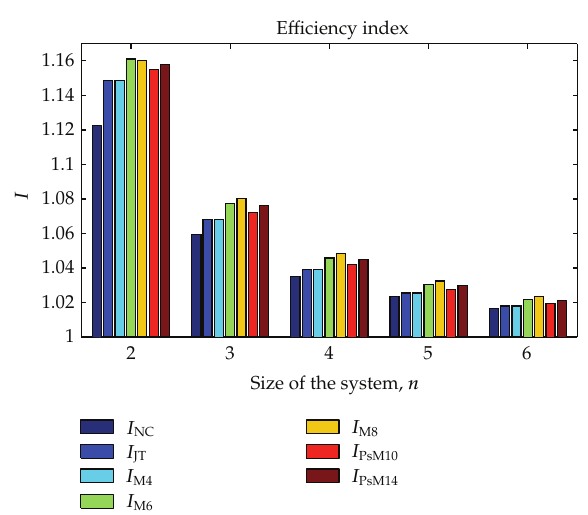
Figure 1: E ffi ciency index of the di ff erent methods for di ff erent sizes of the